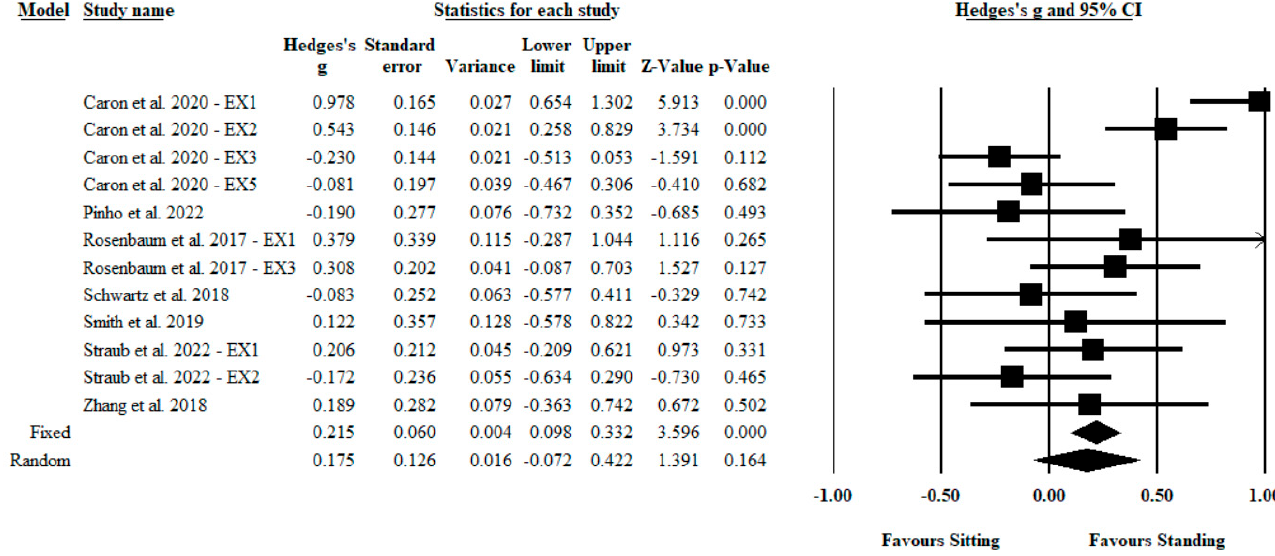
Figure 4. Forest plot of the Hedges’ g differences between sitting and standing conditions for incongruent